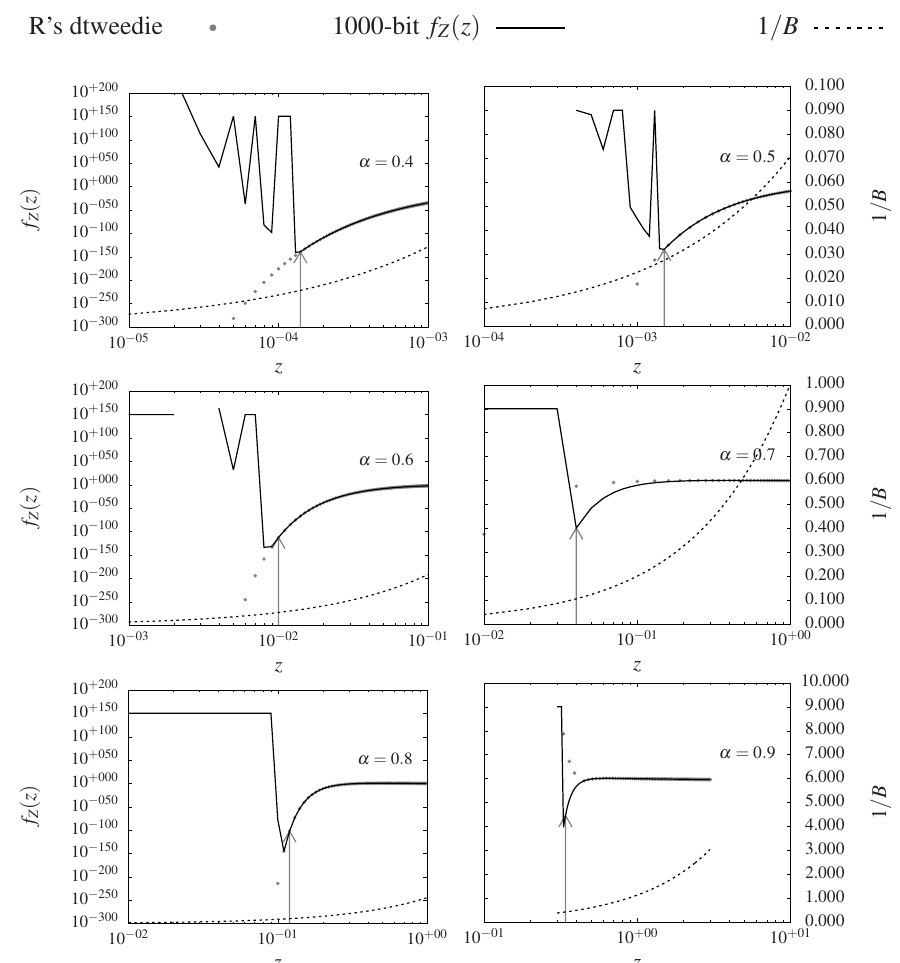
Figure 2 - Transition from unsuccessful to successful calculation of Tweedie densities, for α = 0.4, 0.5, 0.6, 0.7, 0.8 and 0.9. On the left axis scale, the solid line shows the density calculated from summing the series with 1000-bit precision, and the grey circles are the densities calculated by dtweedie in R. On the right axis scale, the dashed line is 1/B . The arrows indicate the first point at which the series summation is considered “successful”. In all cases, θ = –1/2